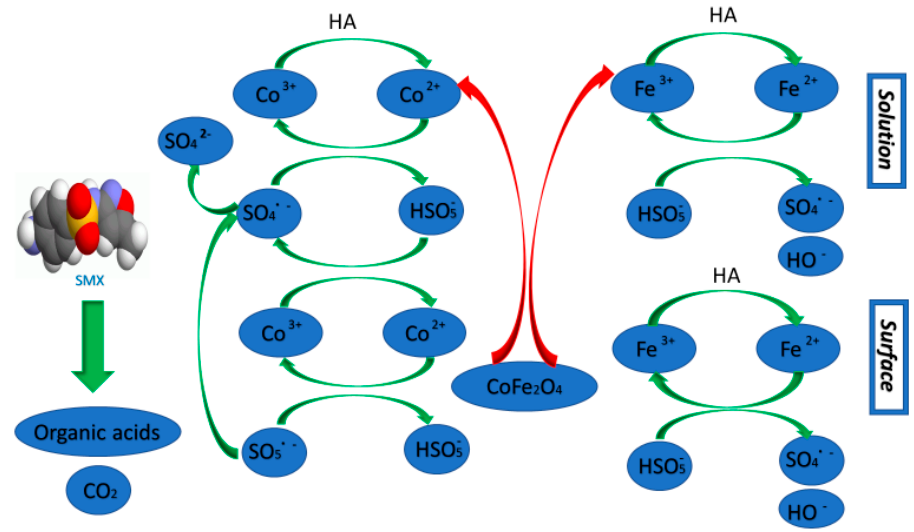
Figure 8. Proposed reaction mechanism for the SMX degradation by a CoFe 2 O 4 /PMS/HA system [114].